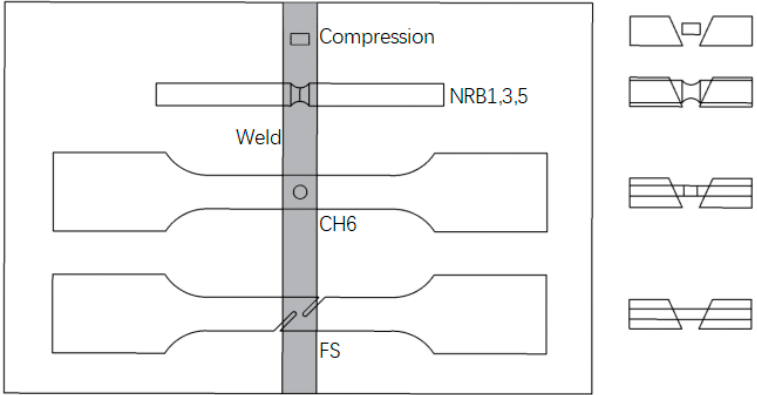
Figure 4. Weld joint (dimensions in mm).